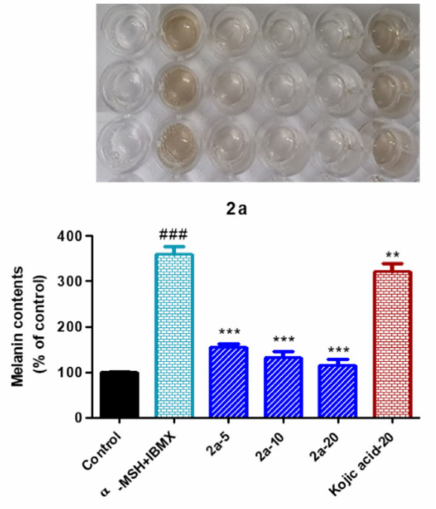
Figure 13. Suppression of melanogenesis in murine B16F10 cells in the presence of 1 µ M α -MSH plus 200 µ M IBMX by 2a. B16F10 cells were treated with 0, 5, 10, or 20 µ M of 2a for 48 h in the presence of α -MSH and IBMX. Melanin levels were measured at 405 nm. Columns represent the means ± SEMs of three determinations. Data are expressed as percentages of untreated controls. ### p < 0.001, vs. untreated controls; ** p < 0.01, *** p < 0.001, versus α -MSH plus IBMX treated